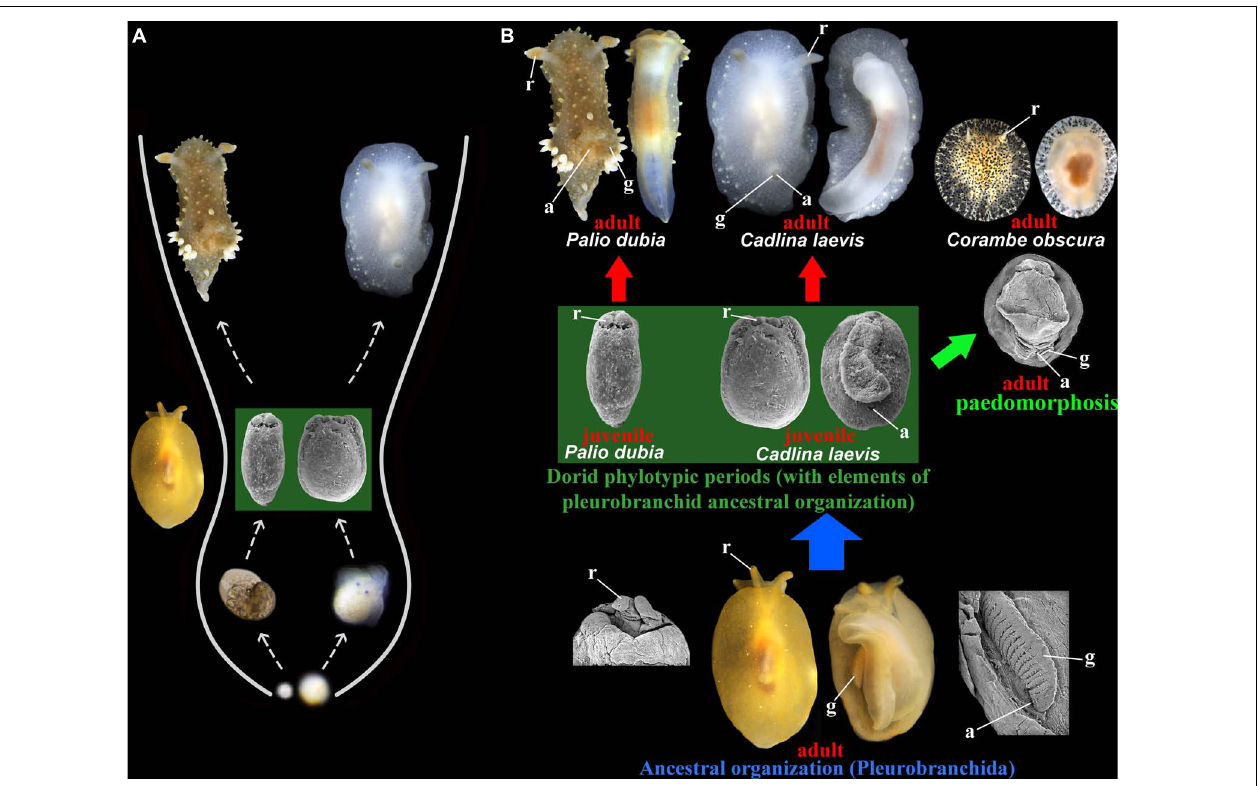
FIGURE 2 | (A) The presentation of phylotypic periods (dark green box) in the disparate at adult phases dorid nudibranch families Polyceridae (represented by Palio dubia ) and Cadlinidae (represented by Cadlina laevis ) showing essentially similar to the classic vertebrate phylotypic period an irregular hourglass-like earlier ontogenetic patterns. (B) Adult morphological disparity (red arrows) and juvenile conservativeness of the dorid nudibranchs manifesting in the phylotypic periods (dark green box). The dorid phylotypic periods keeps several essential features of the adult pleurobranchid organization (joined rhinophores, ventral anus), which is ancestral for dorids. Thus, evolutionary modifications (blue arrow) of the adult pleurobranchid ontogenetic periods into dorid descendant organization partly remains as some key features in the early ontogenetic dorid phylotypic periods. See Korshunova et al. (2020) for molecular phylogenetic data. Dorid paedomorphic taxa (e.g., Corambe obscura , light green arrow) reveal some key features (including ventral anal opening and gills) which link both adult ancestral organization of pleurobranchids and phylotypic periods of majority of non-paedomorphic dorids. a, anal opening, g, gills, r, rhinophores.